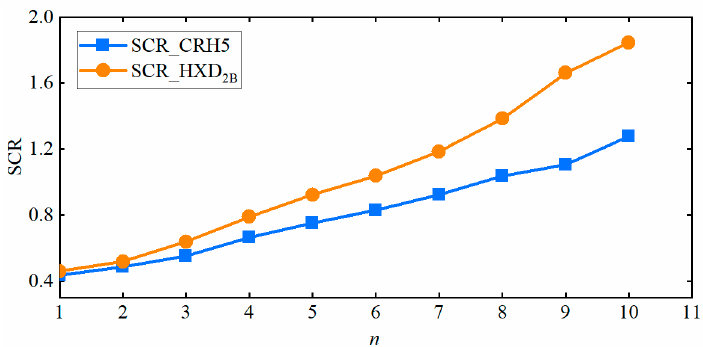
Figure 15. The relationship curve between the number of trains n and SCR.